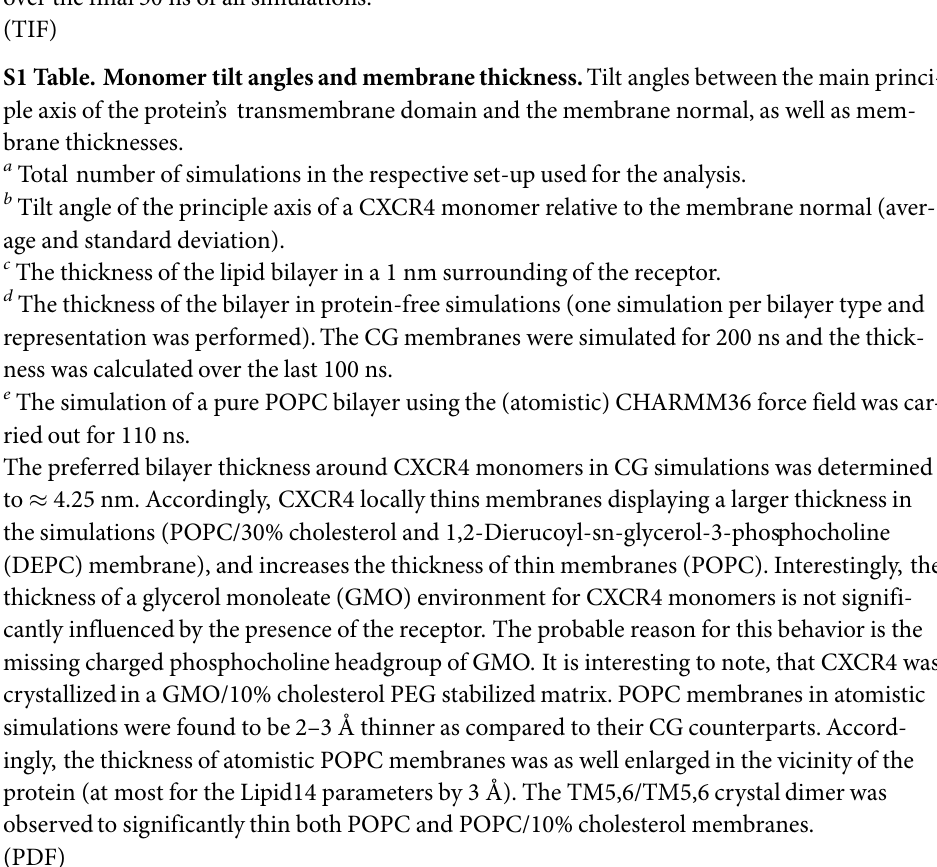
S4 Fig. Spatial distribution function of cholesterol around CXCR4. The spatial distribution functions of the five nearest cholesterol molecules around CXCR4 are shown in light orange, distribution functions of the polar headgroup of cholesterol (ROH beads) are colored dark red. CXCR4 is colored according to the scheme established in Fig 1. The increasing cartoon thick- ness codes the residue-resolved cholesterol occupancy (compare Fig 4). S5 Fig. Cholesterol occupancyin POPC with 30% of cholesterol. Cholesterol binding occu- pancy in simulations of CXCR4 dimerization at 30% cholesterol concentration. The increasing cartoon thickness and coloring scheme code the relative cholesterol occupancies, from 0% (thin, blue) to 100% (thick, red). S6 Fig. Intercalation of cholesterol at dimer interfaces. Probability of finding at least one cholesterol molecule at different dimer interfaces for both mixed bilayers (top panel) and the number of intercalating cholesterol molecules (bottom panel). The analysis was performed over the final 50 ns of all simulations. S1 Table. Monomer tilt angles and membrane thickness. Tilt angles between the main princi- ple axis of the protein’s transmembrane domain and the membrane normal, as well as mem- brane thicknesses. a Total number of simulations in the respective set-up used for the analysis. b Tilt angle of the principle axis of a CXCR4 monomer relative to the membrane normal (aver- age and standard deviation).